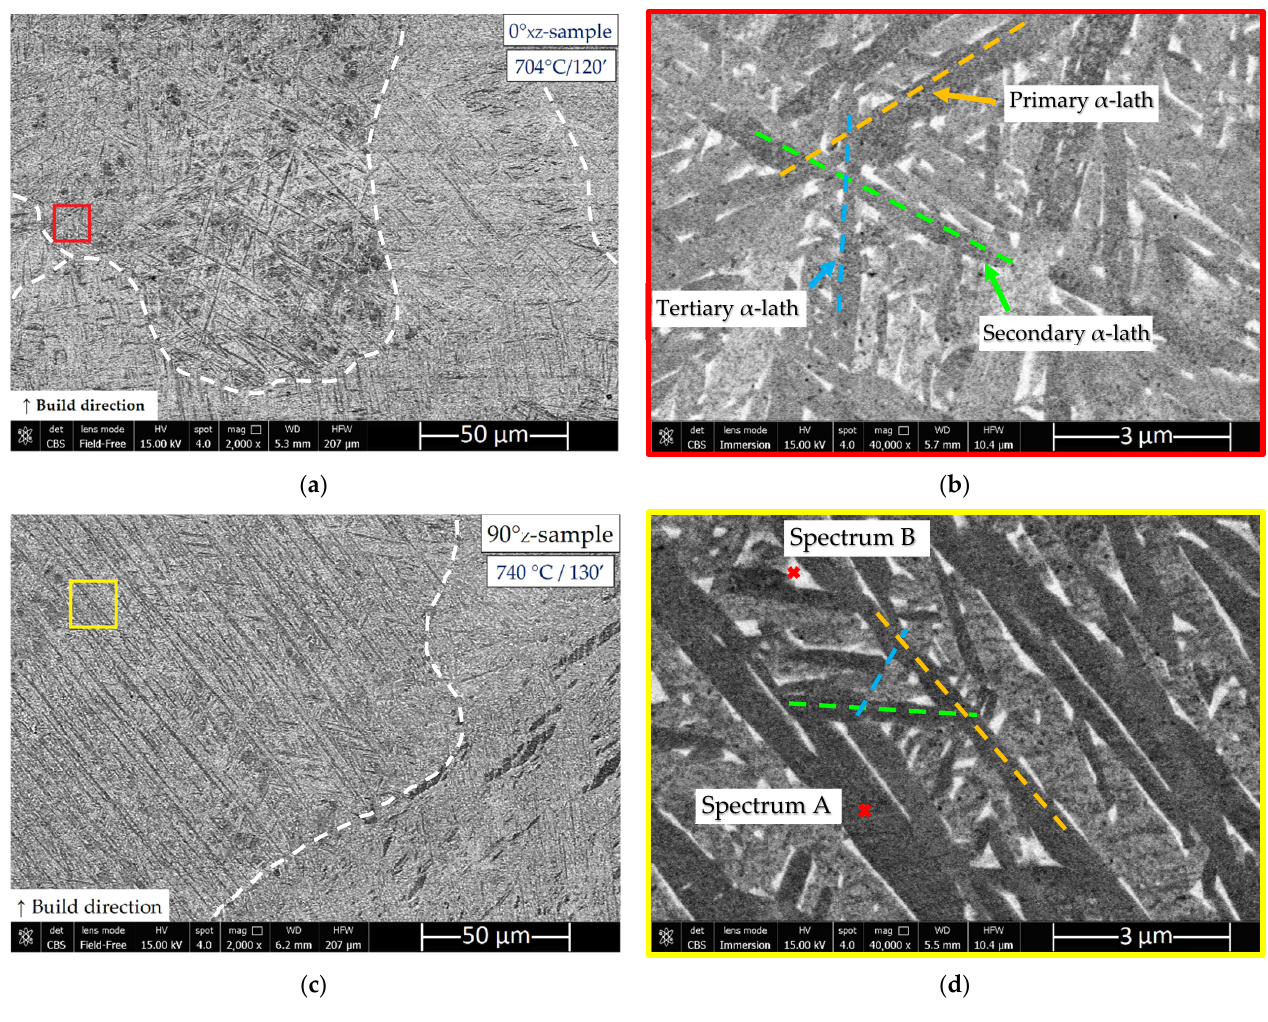
Figure 4. OM micrographs of the microstructure of as-built Ti6Al4V-ELI 45°-sample observed: ( a ) on the plane perpendicular to the build platform, and ( b ) and on the plane parallel to the build platform. White and green arrows indicate the boundaries of the columnar β -grains (white dotted lines) and the laths of α′ -martensite, respectively. The yellow dotted lines represent the molten pool boundary ( a ), and the laser scan tracks ( b ).